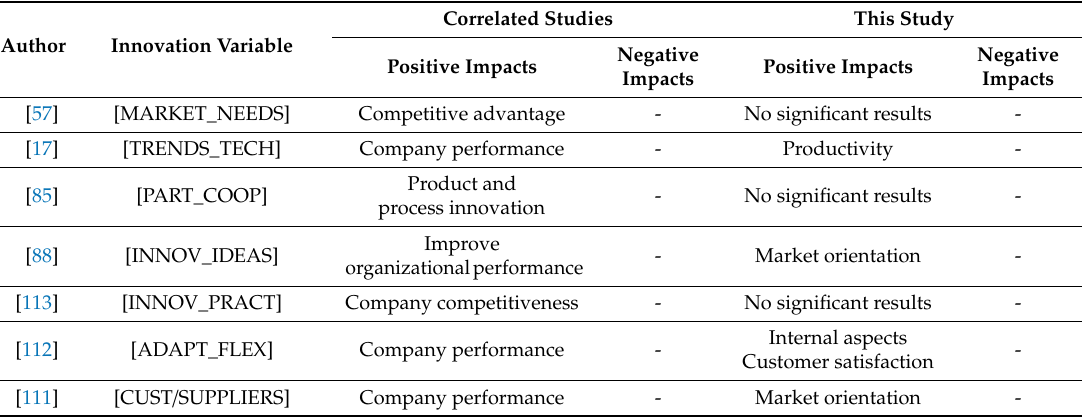
Table 8. Comparison with other